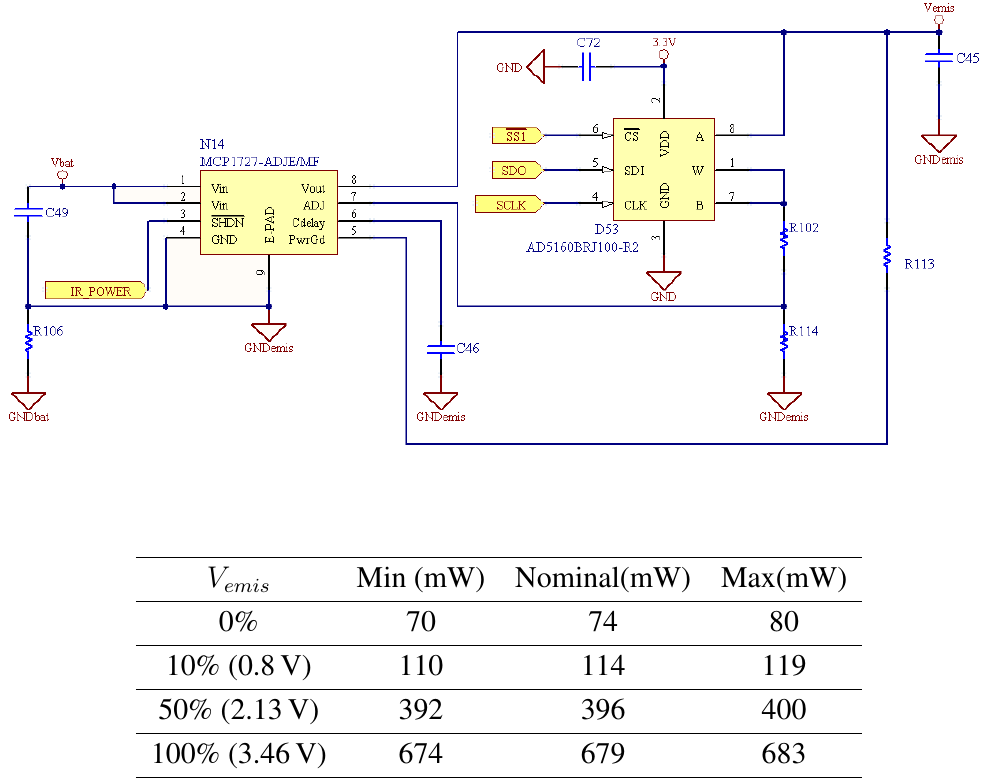
Figure 4. Schematic of the power supply in charge of the emission module.